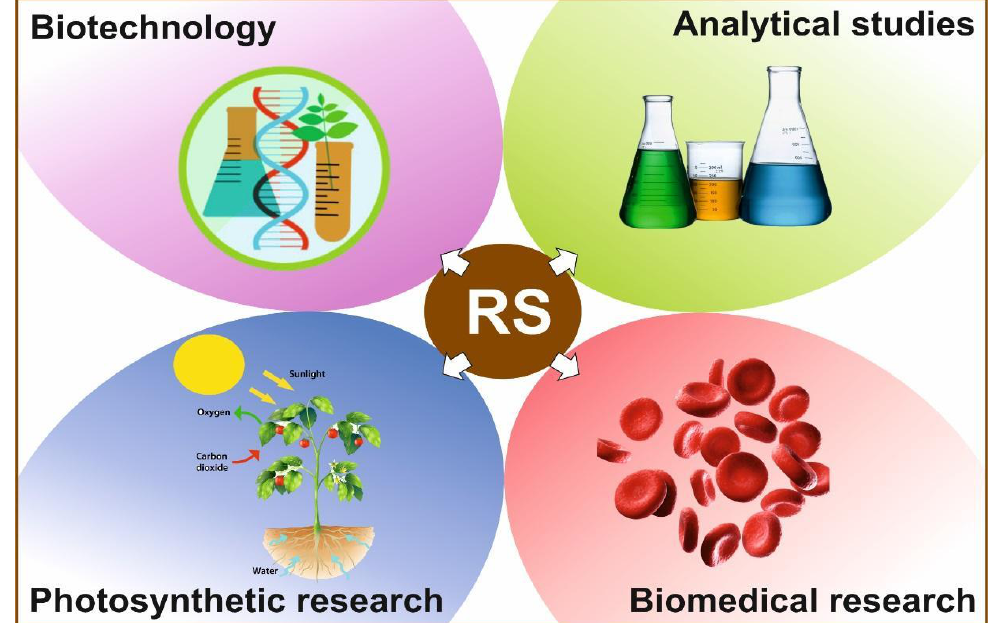
Figure 1. Application of RS in different